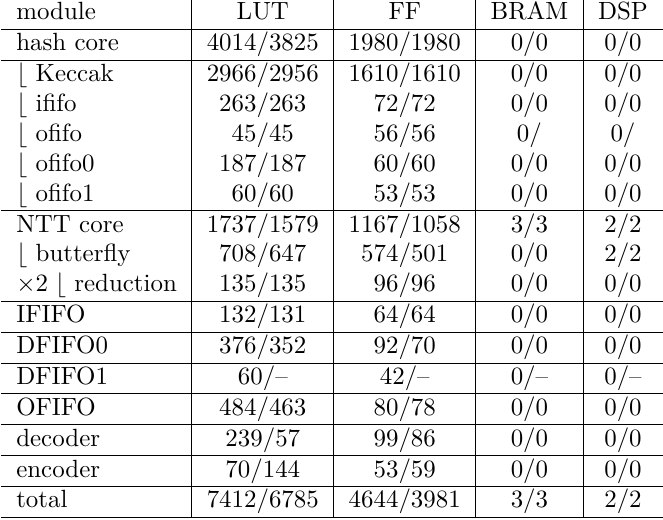
Table 4: Resource consumption of server/client and major submodules